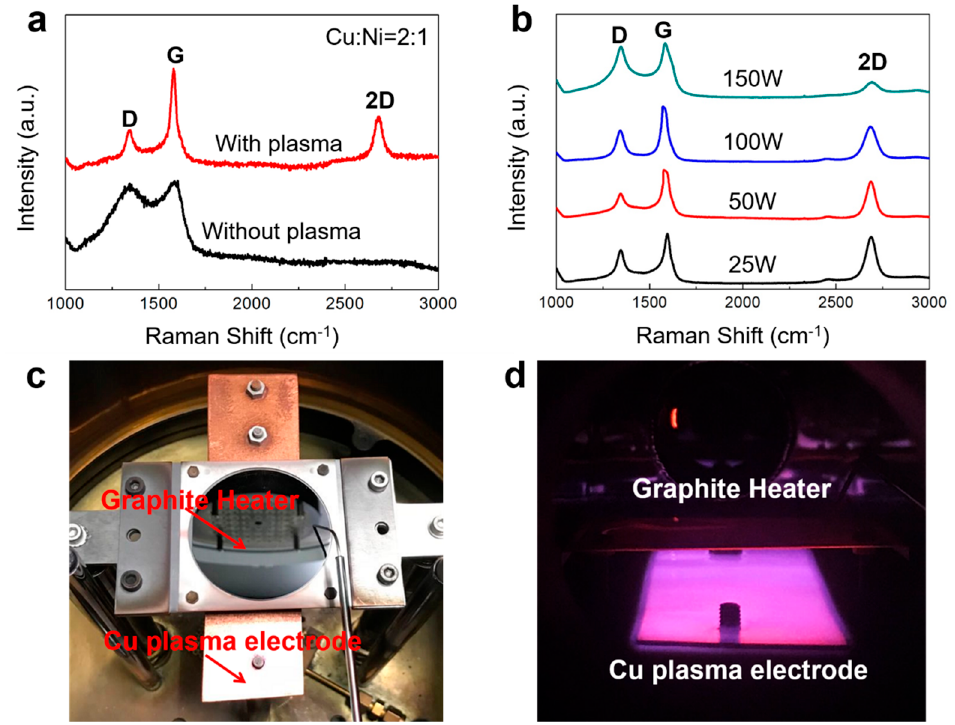
Figure 4. ( a ) Raman spectra of the graphene grown with and without plasma at 600 °C. ( b ) Raman spectra of the graphene grown with different plasma powers. ( c ) The photograph of the growth chamber. ( d ) The photograph taken during the growth process.